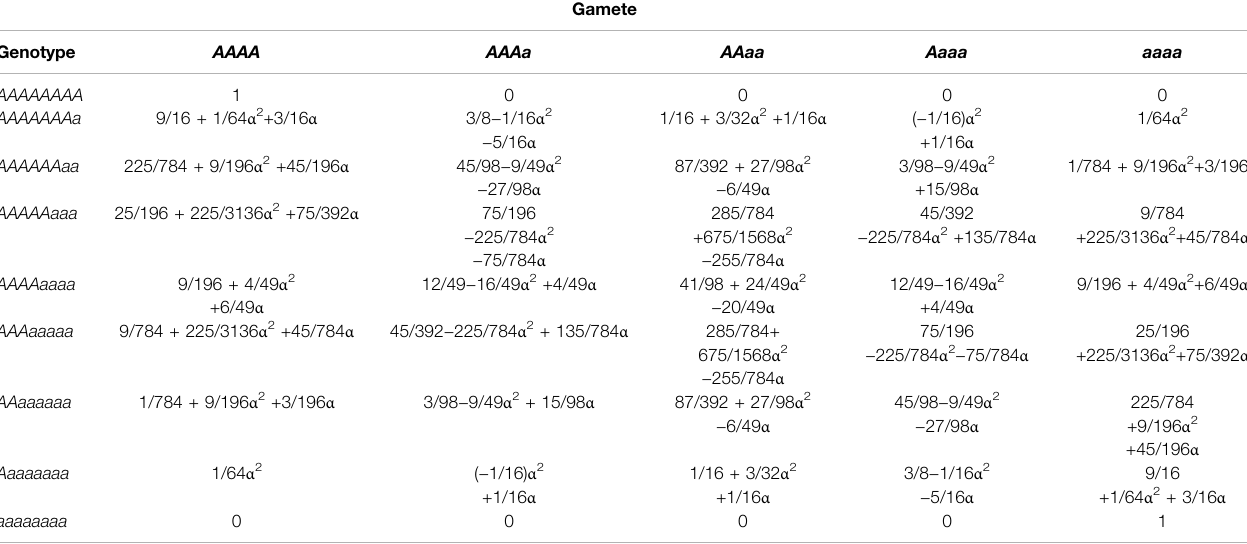
TABLE 1 | Gamete frequencies generated by different autooctoploid genotypes.